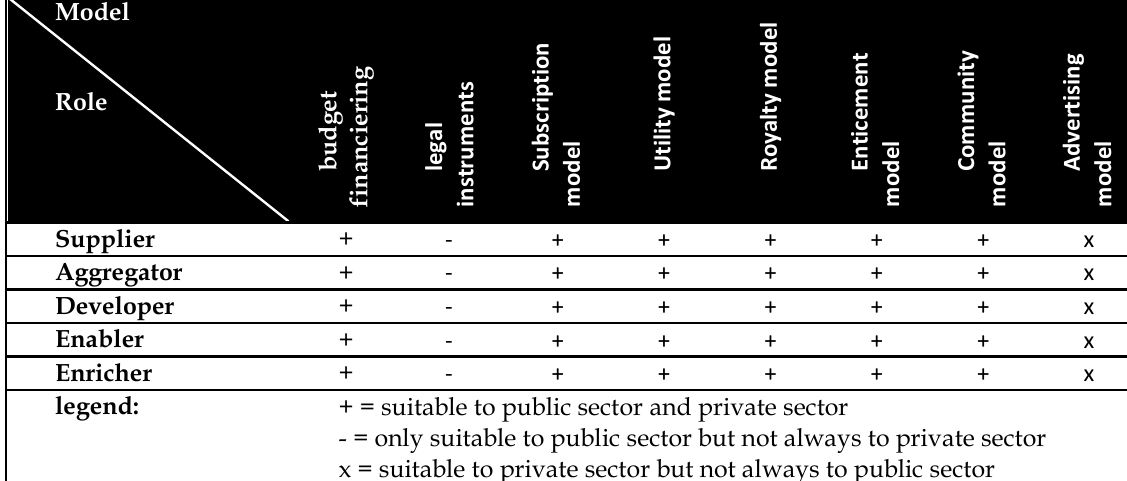
Table 2: Relation between roles and revenue models, and suitability to public sector and private sector.